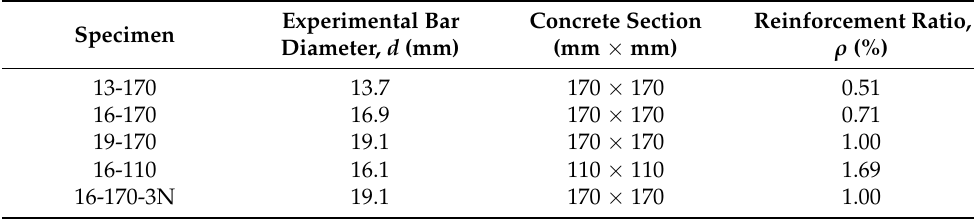
Table 1. Test matrix on tensile elements